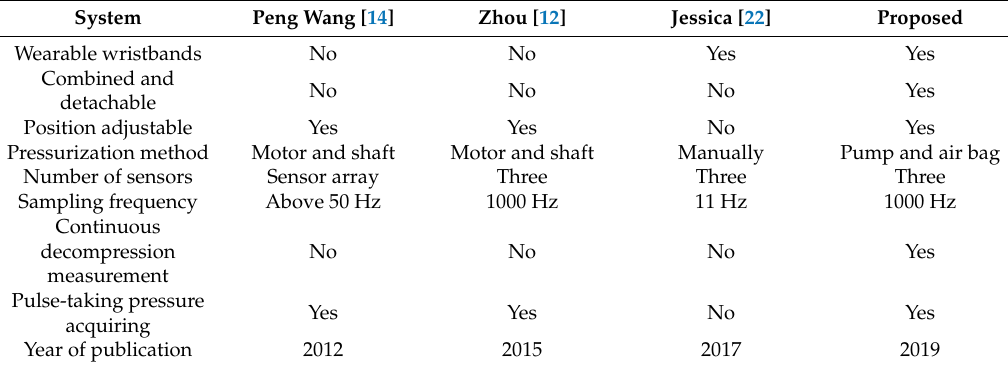
Table 3. Comparisons with other pulse measurement